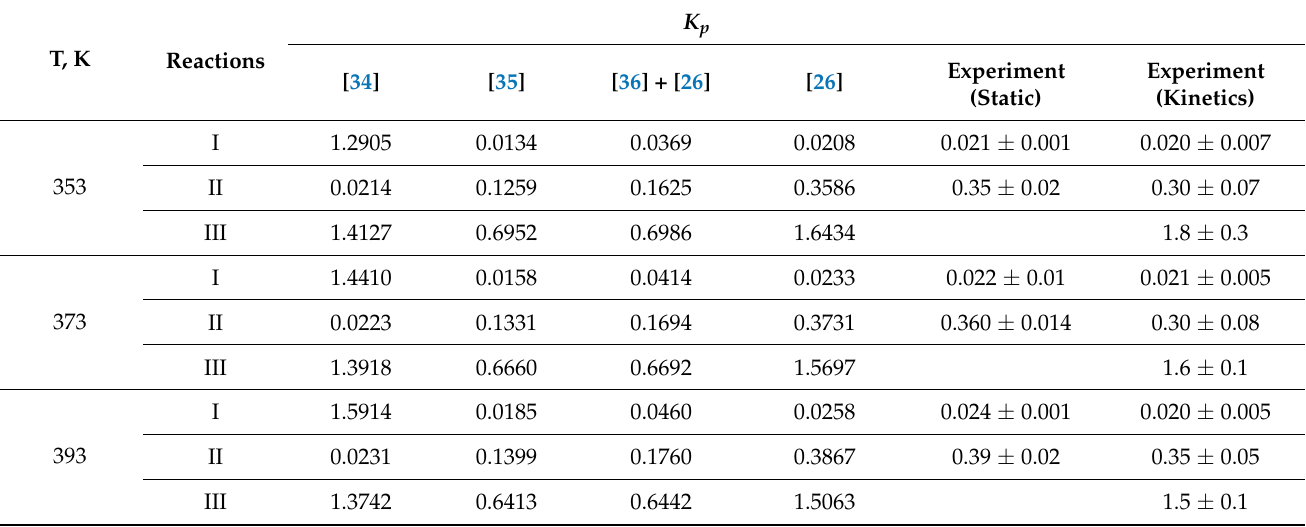
Table 5. Equilibrium constants of reactions (1)–(3) calculated according to the literature data [26,34–37] and obtained as a result of the experiment for temperatures 353, 373, and 393